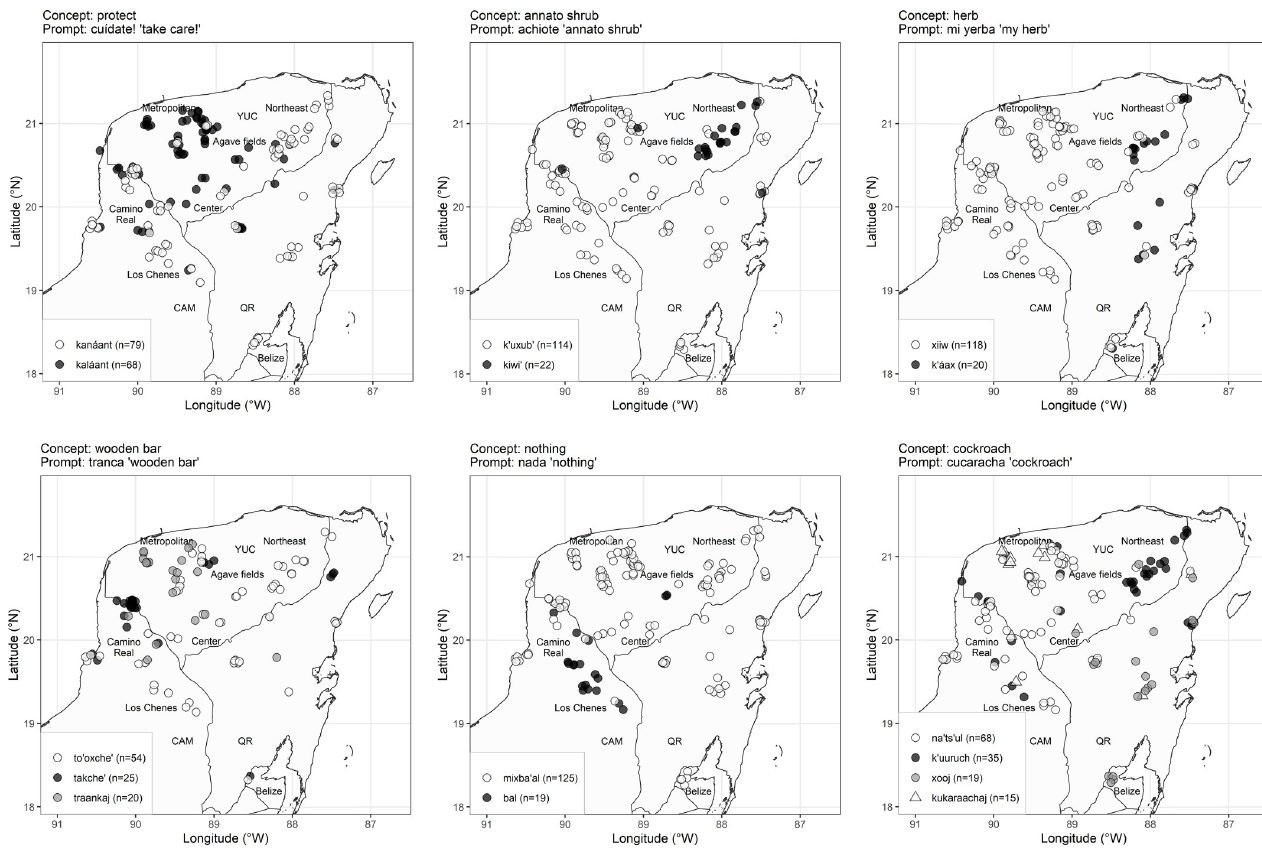
Fig 6. Variants in geographical